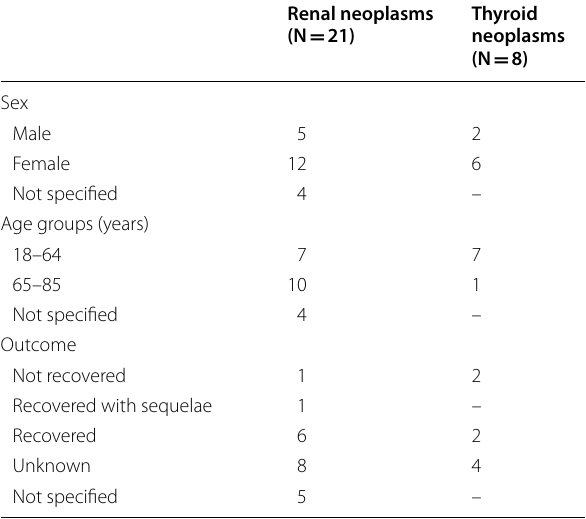
Table 3 Demographic characteristics and outcome in renal